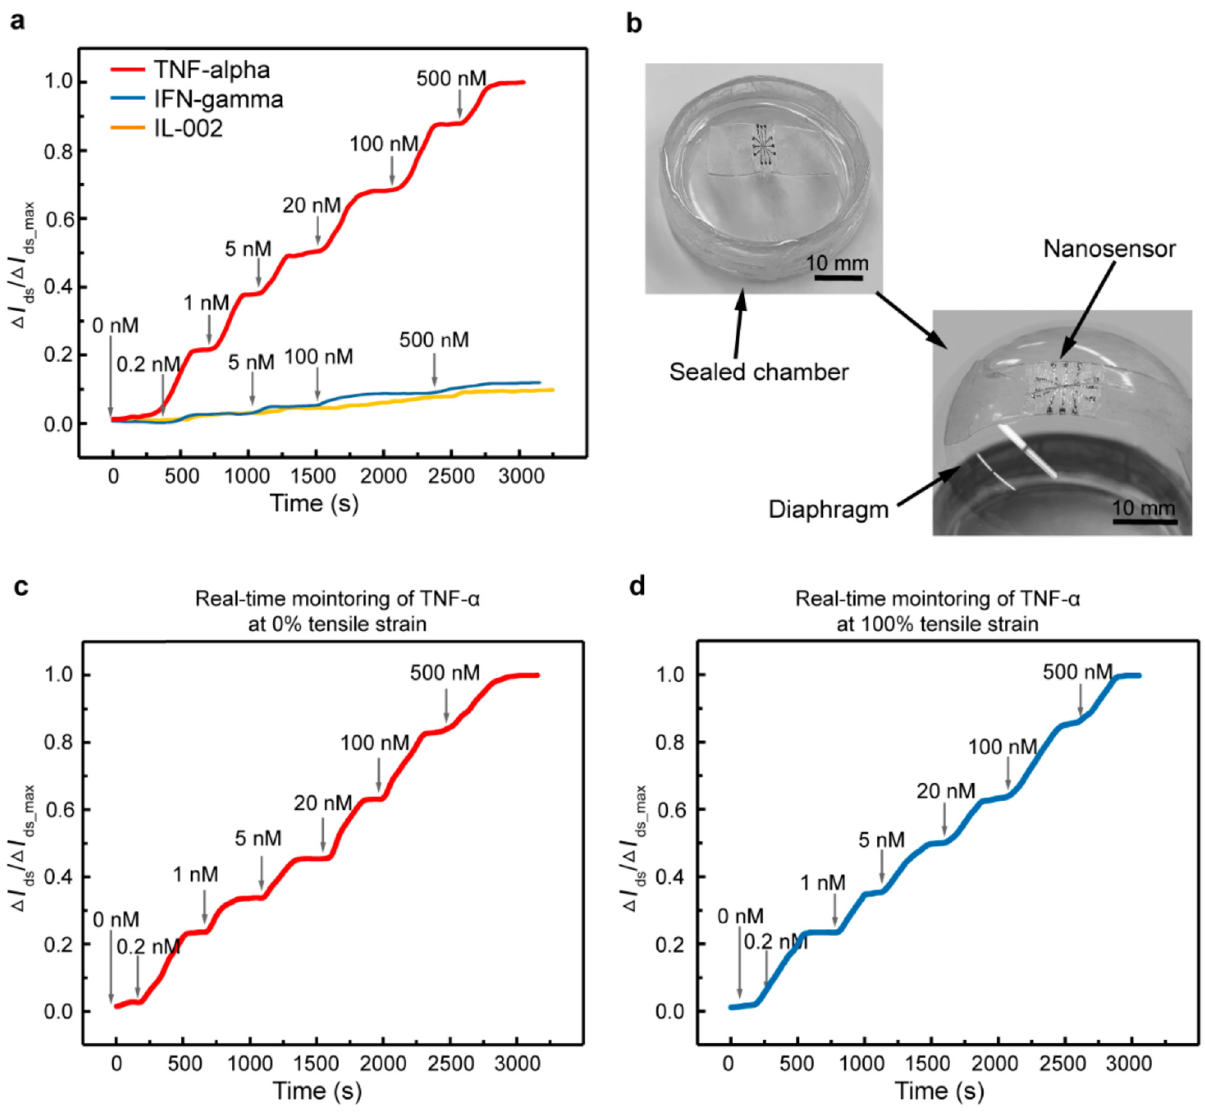
Figure 15: Time - resolved measurement of cytokines. ( a ) Real - time monitoring of TNF - α protein and control protein ( IFN - γ and IL - 002 ) in arti fi cial tears. ( b ) Photograph showing the biosensor stretched by the in fl ated diaphragm chamber. Real - time monitoring of TNF - α using the biosensor at ( c ) 0% and ( d ) 120% tensile strain [ 107 ]